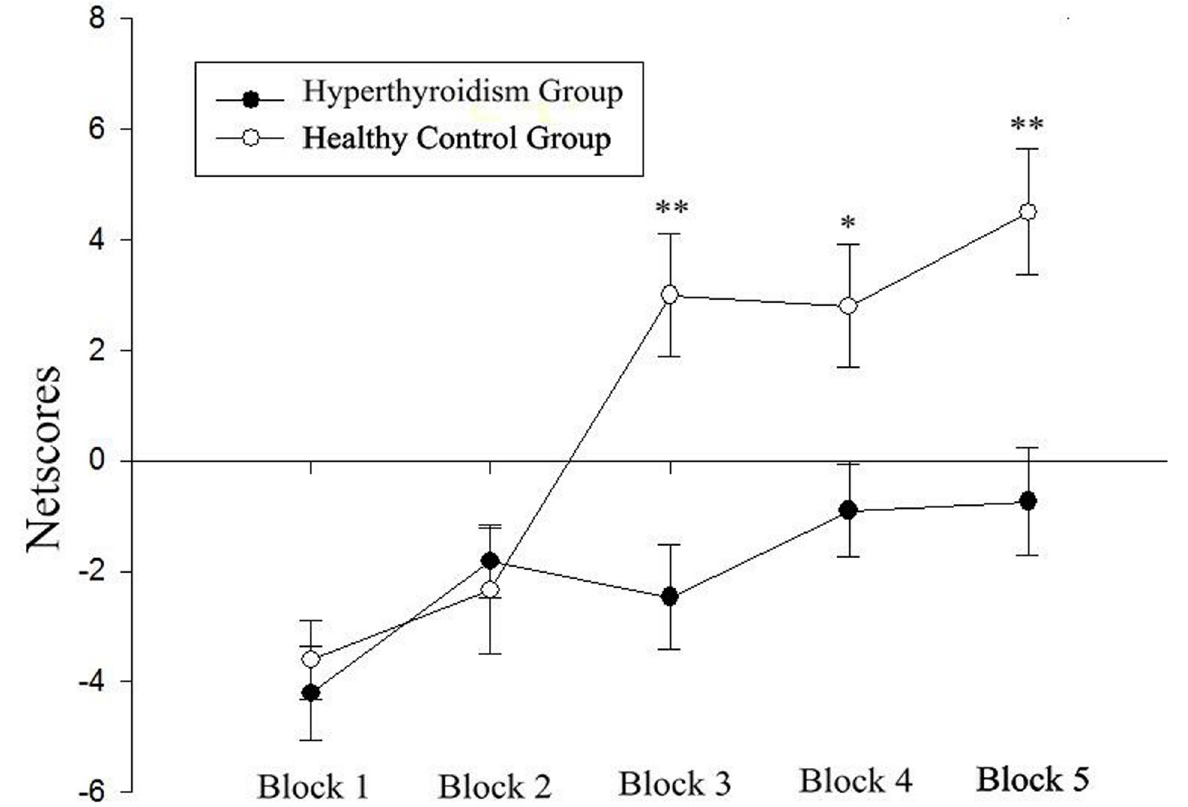
Fig 2. The mean net scores of the 5 blocks, consisting of 20 trials each, for the hyperthyroidism group and the healthy control group. Error bars indicate standard errors of the mean. Items marked with * : p < 0.05. Items marked with ** : p <